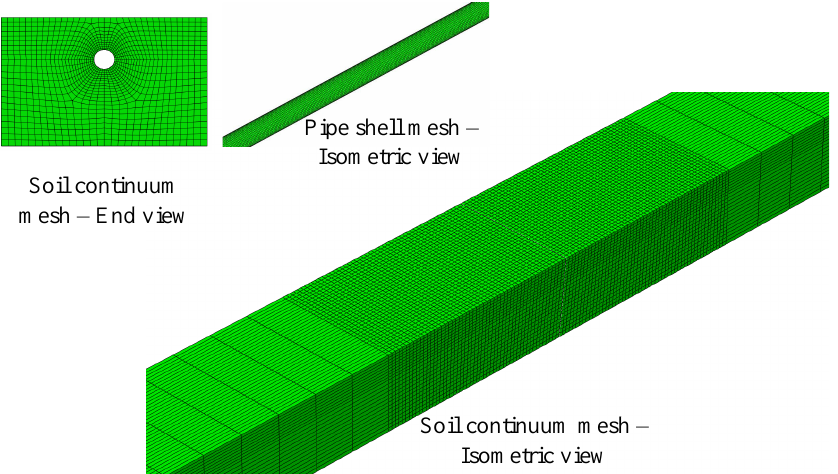
Figure 3. High-fidelity model